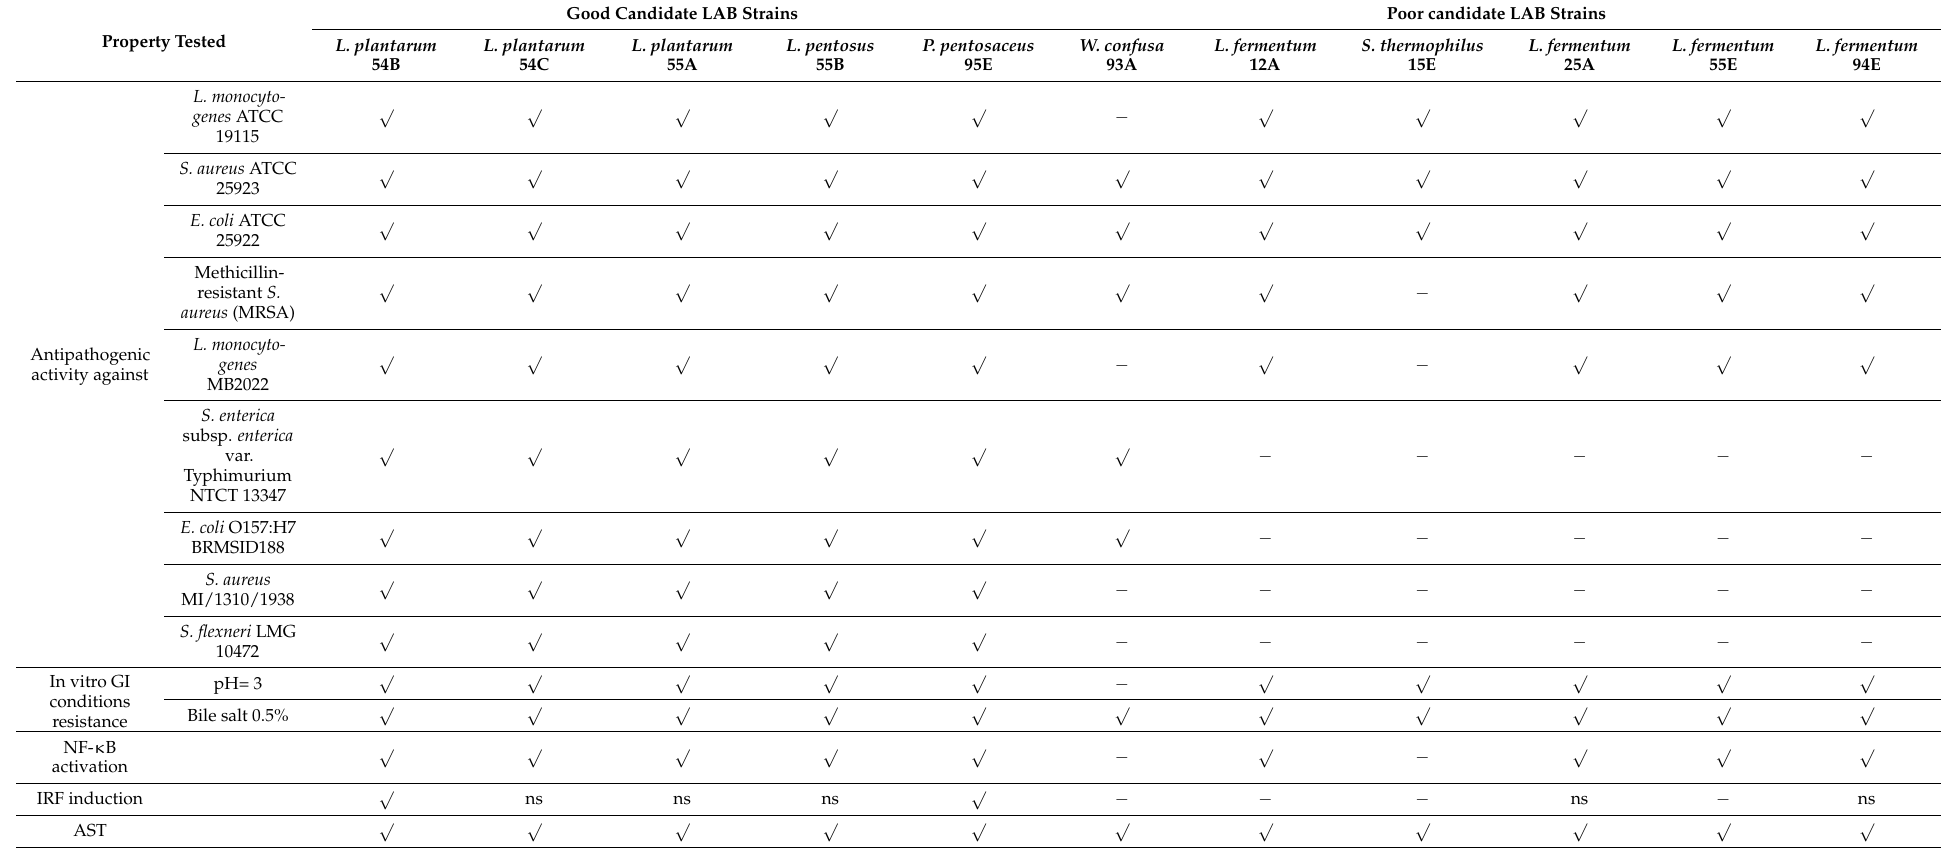
Table 4. Summary of results of probiotic properties of LAB strains to select as candidate